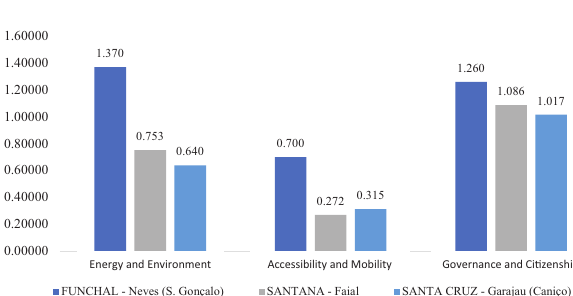
Figure 4. Weighted partial assessments of Neves, Faial, and Garajau residential